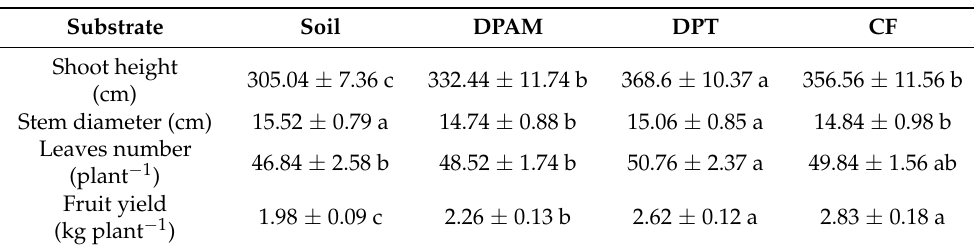
Table 2. Growth parameters of 5 months old melon plants cultivated on different substrates. DPAM: compost of date palm residues and animal manure; DPT: compost of date palm trunk; CF: coconut fiber, compared with soil